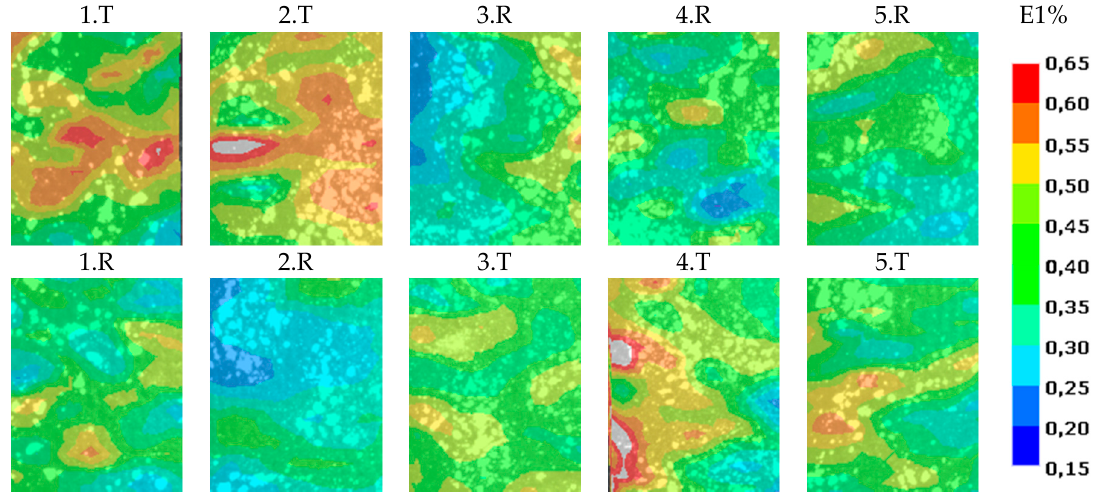
Figure 5. Comparison of longitudinal strains of specimens 1 – 5. during the tensile test at the 0.4% average strain condition.